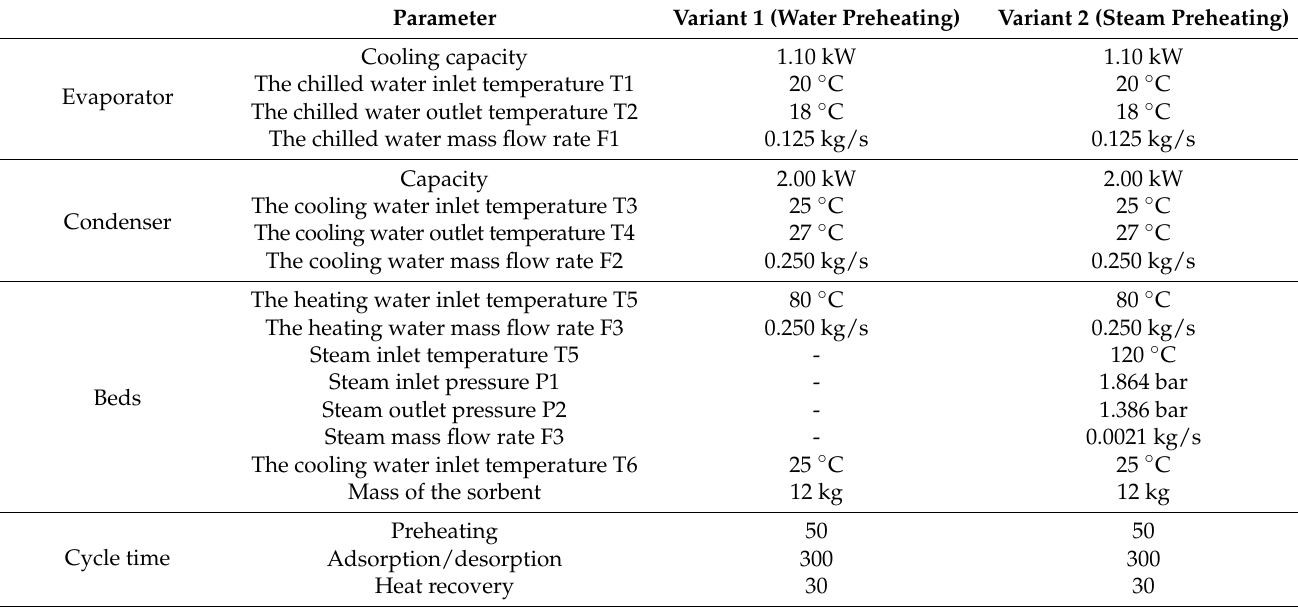
Table 4. Chiller operating parameters in two variants of